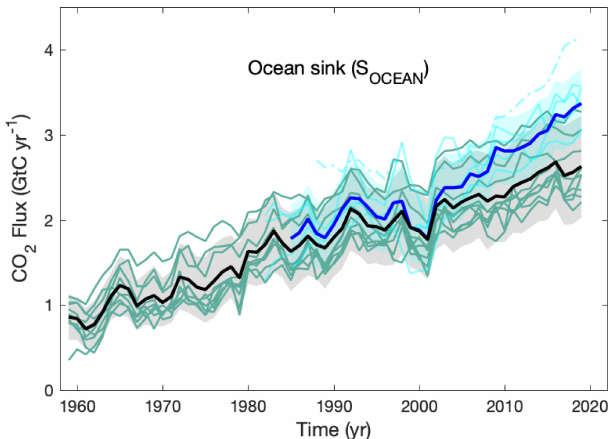
Figure 7. Comparison of the anthropogenic atmosphere–ocean CO 2 flux showing the budget values of S OCEAN (black; with ± 1 σ uncertainty in grey shading), individual ocean models (teal), and the ocean p CO 2 -based flux products (ensemble mean in dark blue, with ± 1 σ uncertainty in light blue shading – see Table 4; individ- ual products in cyan; Watson et al. (2020) as a dashed–dotted line not used for ensemble mean). The p CO 2 -based flux products were adjusted for the pre-industrial ocean source of CO 2 from river input to the ocean, which is not present in the ocean models, by adding a sink of 0.61GtCyr − 1 to make them comparable to S OCEAN (see Sect.